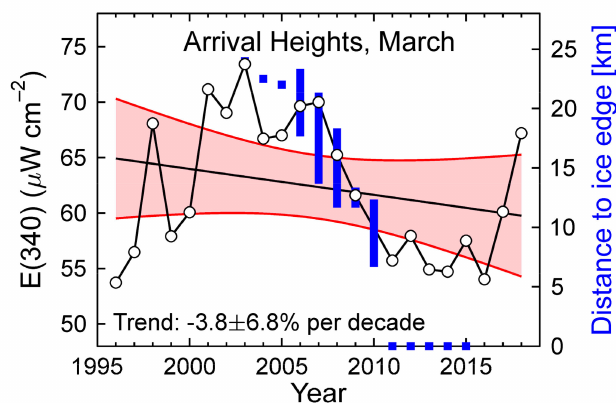
Figure 5. Comparison of spectral irradiance at 340 nm (E(340), left axis) at Arrival Heights and distance of the fast ice edge from McMurdo (right axis) during March. Distance data are based on Figure 3 by Kim et al. [25]. The vertical extension of the blue bars indicates the variability of the distance within the month of March. The red-shaded area indicates the 95% confidence interval about the regression (black